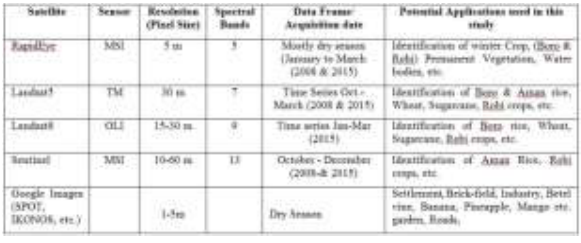
Sources: website of respective satellite vendors and ERDAS Tour